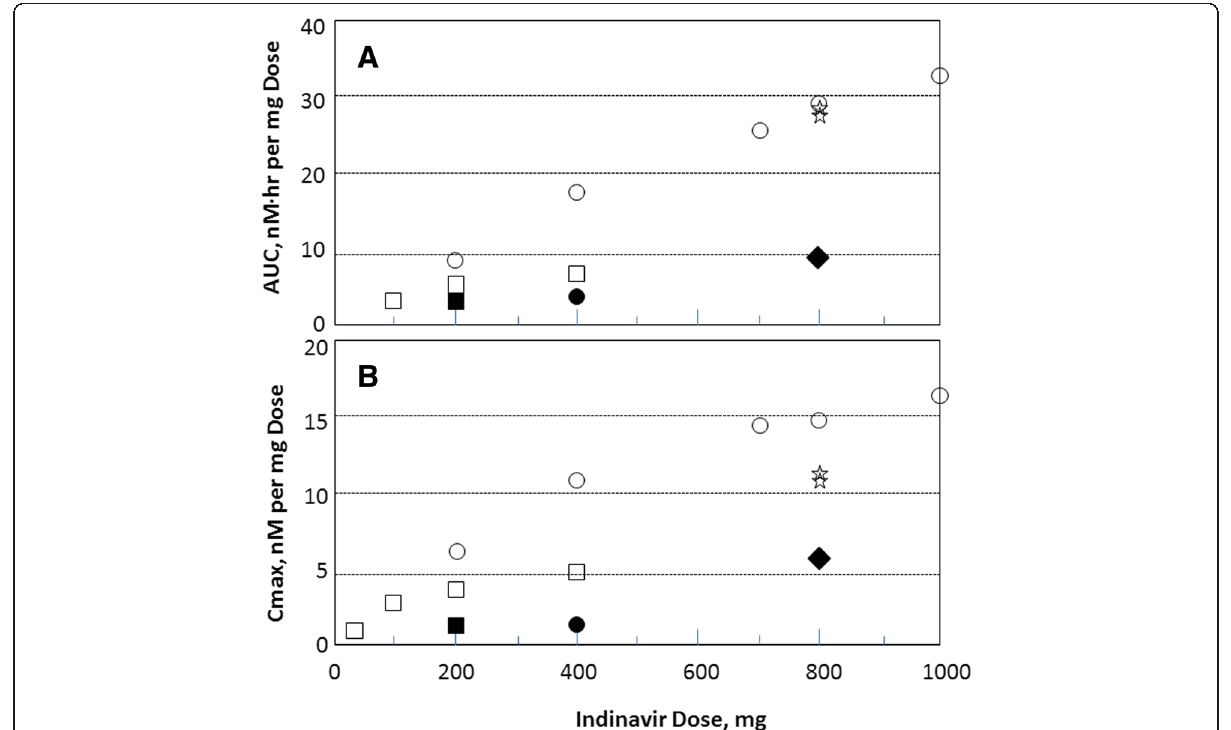
Fig. 5 AUC ( a ) and Cmax ( b ) curves for indinavir as a function of the administered single-dose; AUC and Cmax values were normalized to a 1-mg dose. ○ sulfate salt fasted state; ● sulfate salt following a high-fat meal; ☆ sulfate salt following low fat meal; □ free-base capsules fasted state;